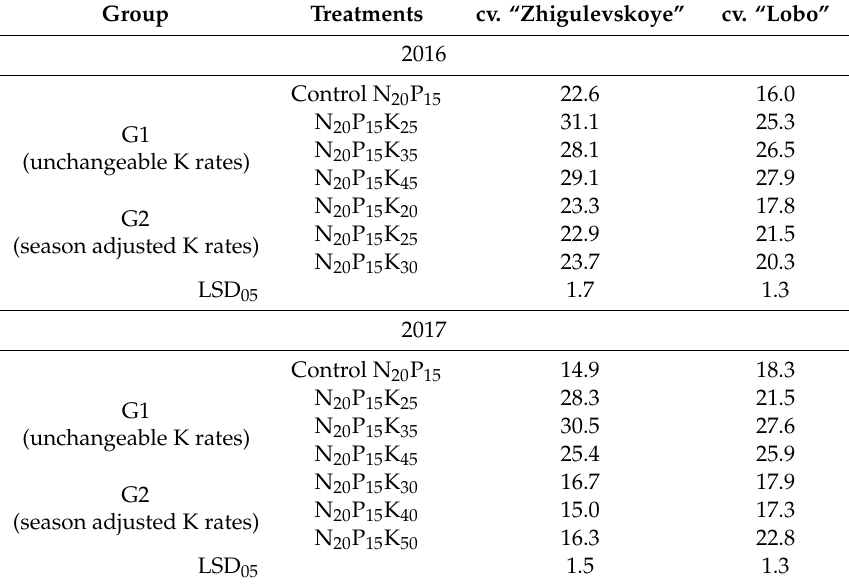
Table 17. The e ff ect of di ff erent potassium fertilization rates and fertigation approaches on the K / Ca ratio in apple